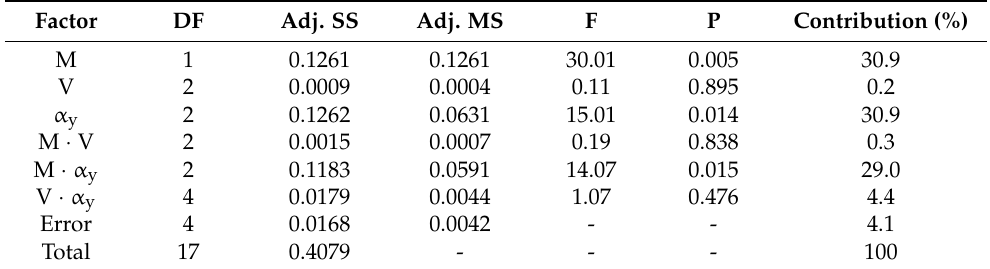
Table 6. ANOVA analysis results for R a .